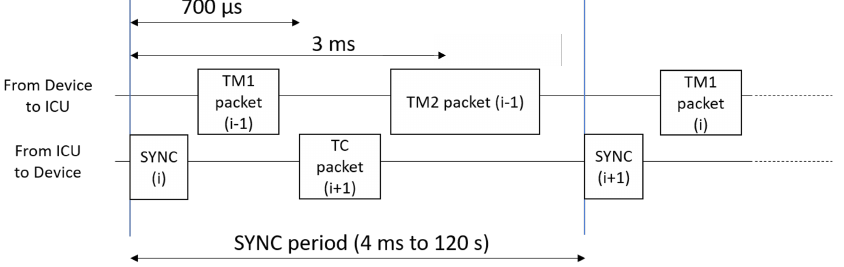
Figure 3. Time diagram of ICU-device